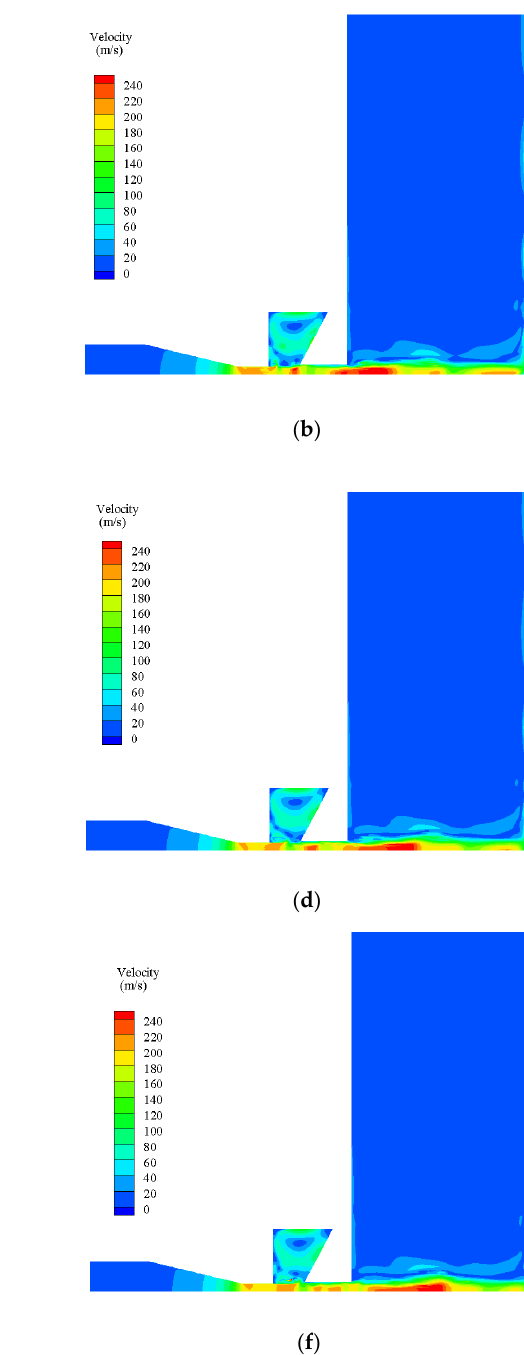
( a ) ( b ) Figure 8. ( a ) Non-dimensional velocity magnitude at different axial locations ( b ) Non-dimensional velocity magnitude at different radial locations. 3.2. Erosion Pattern on Specimen Surface The cavitation damage caused by the HSEOW nozzle on the specimen was mainly the jet cavitation cloud under submerged conditions (see Figure 9) [23,24]. The circular honeycomb dense holes took shape in a radial distribution near the center. The core area of jets was concentrated in the circular area at the center, and the bubble cloud carried by jets collapsed on the target surface. Numerous dense micro-jets repeatedly impacted on the surface so that dense holes were formed. In the vicinity of the central region, the damage was distributed radially due to the stress wave effect. The density of holes and the damage intensity weakened with the increase of distance.